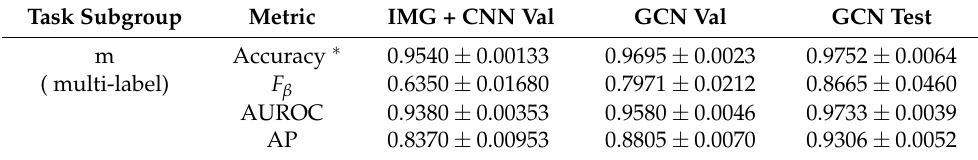
Table 4. Results of multi-label classification for the 8336 molecules with an average of 1.2 classes assigned to each molecule for validation and 4610 molecules with an average of 2.7 classes assigned to each molecule for testing. We first compare the previous IMG + CNN to our GCN model on cross validation. This information is provided in the columns IMG + CNN Val and GCN Val, respectively. In addition, in the GCN Test column, we provide results of our GCN model on test data. For the F β score, β = 2 was used, as in previous methods. Notice that this favors recall over precision according to Equation (7).